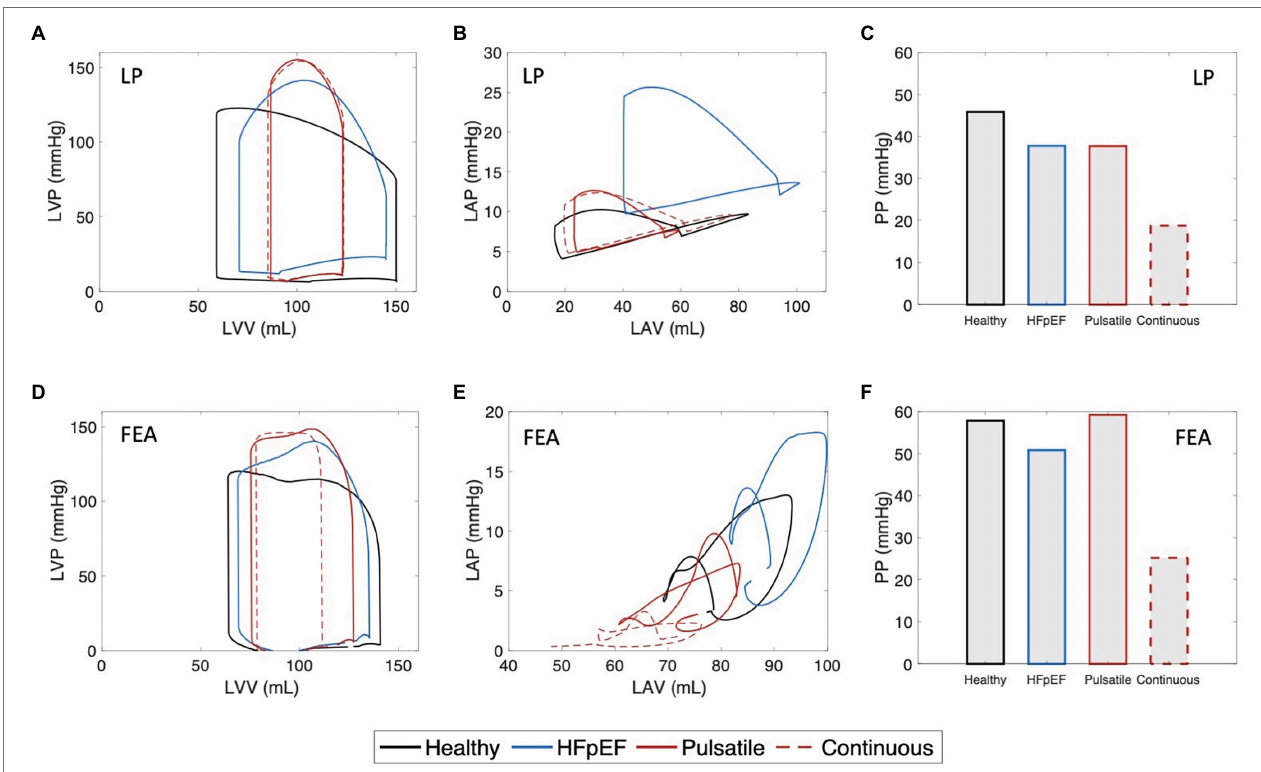
FIGURE 5 | Hemodynamic results from lumped-parameter (LP) and finite element analysis (FEA) modeling. (A) Left ventricular (LV) pressure-volume (PV) loops, (B) left atrial (LA) PV loops, and (C) pulse pressure (PP) values obtained by LP model. (D) LV PV loops, (E) LA PV loops, and (F) PP values obtained by FEA model. Each plot shows comparison between the hemodynamics of the healthy heart, HFpEF, and under pulsatile and continuous pump support. LVP, left ventricular pressure; LVV, left ventricular volume; LAP, left atrial pressure; and LAV, left atrial volume.